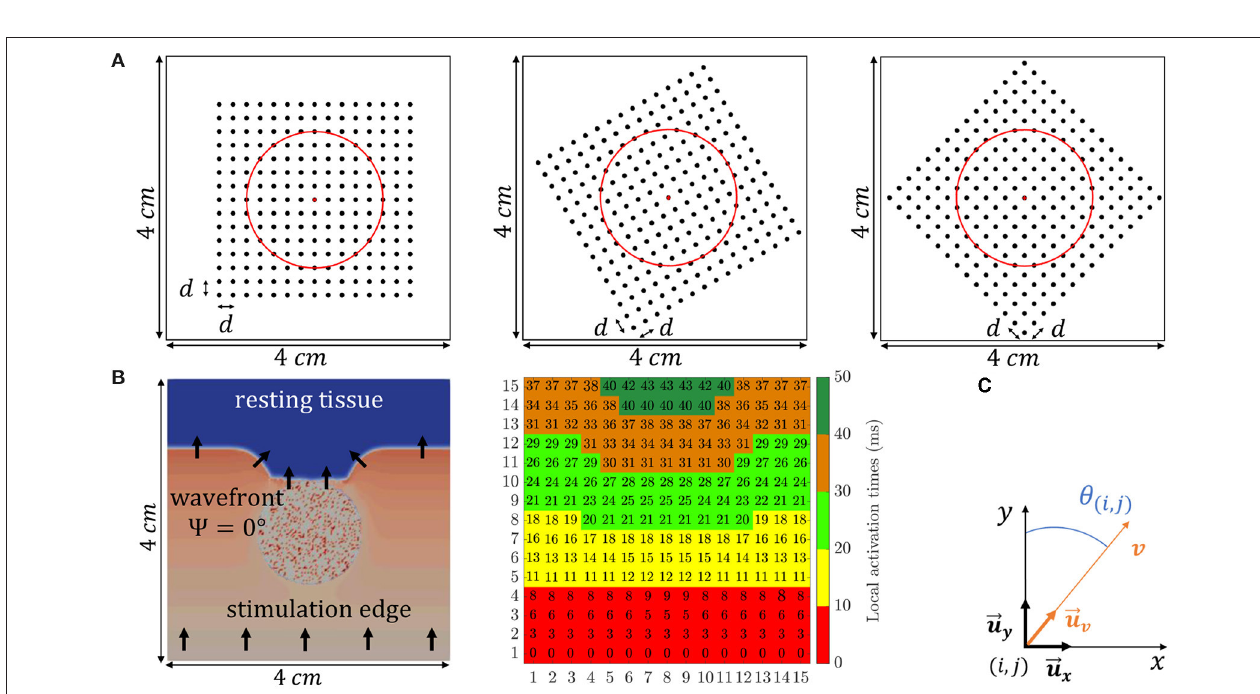
FIGURE 2 | (A) The three different MEA orientations with respect to the tissue considered in this study: 9 (rightmost). ( B , leftmost) Activation distribution at a particular time instant, where black arrows indicate propagating wave direction. ( B , rightmost) Local activation times map representing the propagation pattern. (C) Local 2D Cartesian coordinate system defined by unit vectors −→ u x and −→ u y .